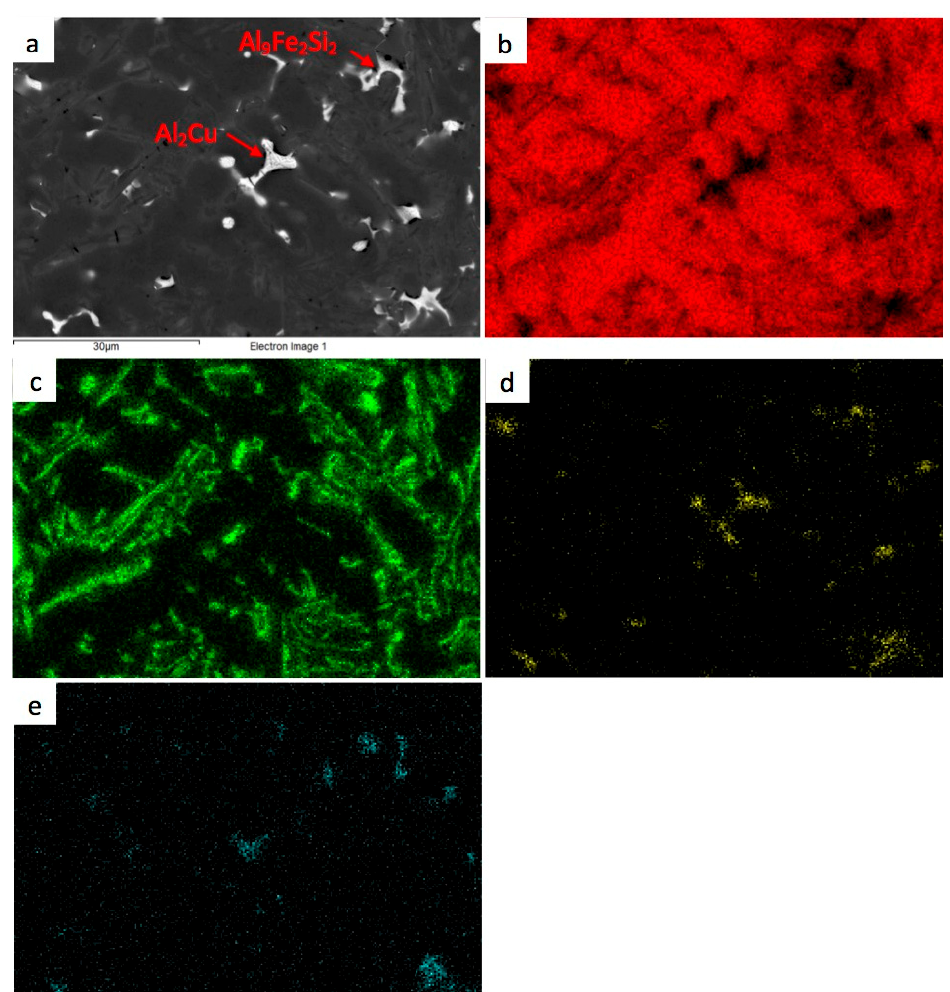
Figure 7. ( a ) SEM image of solidification microstructure and EDX maps of ( b ) Al, ( c ) Si, ( d ) Cu and ( e ) Fe in intermetallic phases for the rapidly quenched Al-18%Si-2%Cu alloy. In contrast to the low-magnification micrographs, Figure 8c illustrates the coarse dendritic character of cleavage facets of the α (Al) solid solution (for example, in the fracture area indicated by white circle), as well as the development of a typical river pattern relief (shown by white arrow in the left side of the image) at a cleavage plane in the case of the primary silicon particle fracture, both of which occur in the conventionally cast sample. Moreover, the presence of almost continuous thick intermetallic phases along the dendrite boundaries (shown by white arrow in the down right side of the image) is also well observed in this figure. In comparison, Figure 8d reflects the fine scale of the cleavage facets for the rapidly quenched alloy at a higher magnification. Furthermore, Figure 8e and f shows, for example, the presence of relatively coarse-branched and fine-branched Al 2 Cu-based intermetallics at the fracture surface for the samples that were conventionally cast and rapidly quenched, respectively. Thus, all these abovementioned fracture features, following the difference in the microstructure of both samples, were consistent with the data obtained in the tensile test (see Table 2). Due to the strong overall microstructure refinement and hence the improved properties, the suggested technology can offer benefits to wear resistance, primarily with respect to cast pistons of internal combustion engines or other parts that are exposed to the heavy dry sliding friction such as, for example, worm wheels used in gearboxes. However, our work requires a more detailed industrial investigation and characterisation.